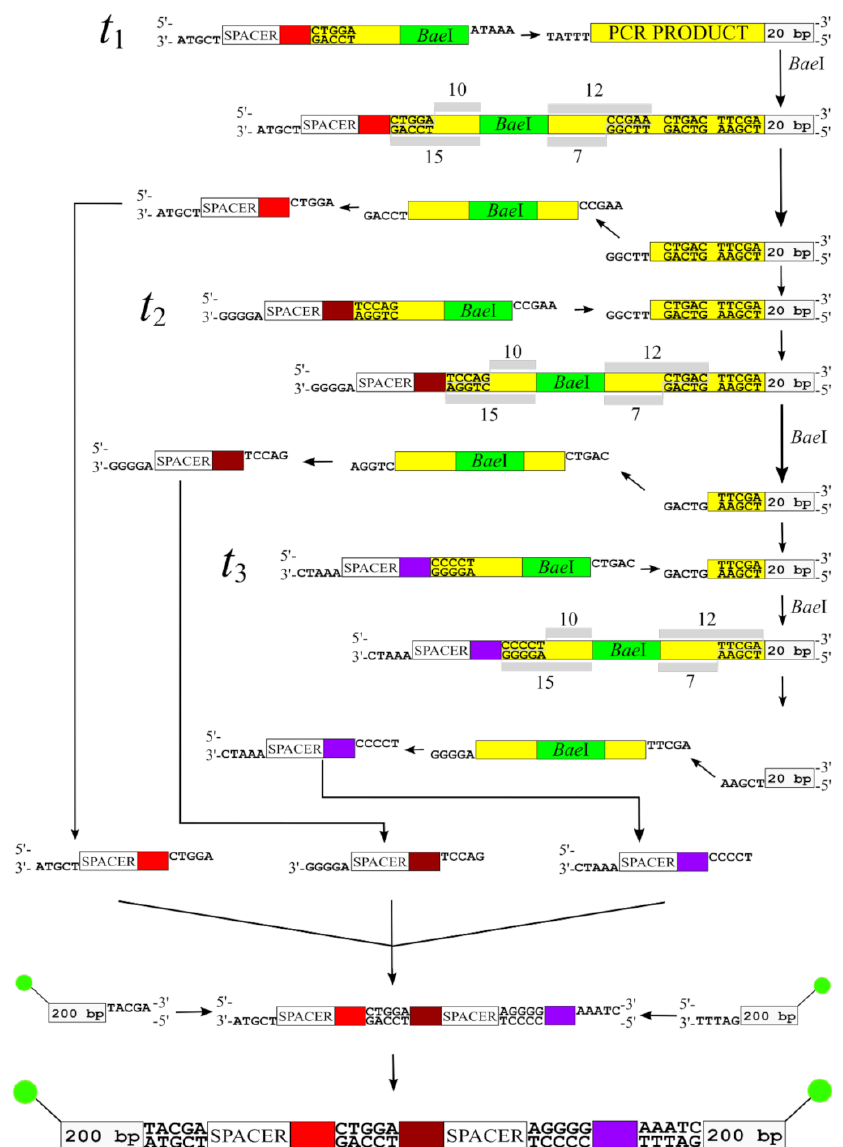
Figure 8. Operation of the restriction enzyme Bae I in a system which reads the genome fragment—reading and writing information into the queue. The molecular software ( t 1 , t 2 , t 3 ) allows alternating and autonomous cleavage of DNA molecules which are genome fragments obtained by the PCR method. The biomolecular computer produces the final DNA fragment, as a standard output, after the cyclic reactions of cutting and ligating the genome fragment obtained by the PCR method. The green circle denotes the factor of fluorescence. The DNA fragments that are cleaved by restriction enzyme ( Bae I) are denoted in yellow. The restriction sites are denoted by light green color. The other colors schematically illustrate the queue symbols that are placed in the